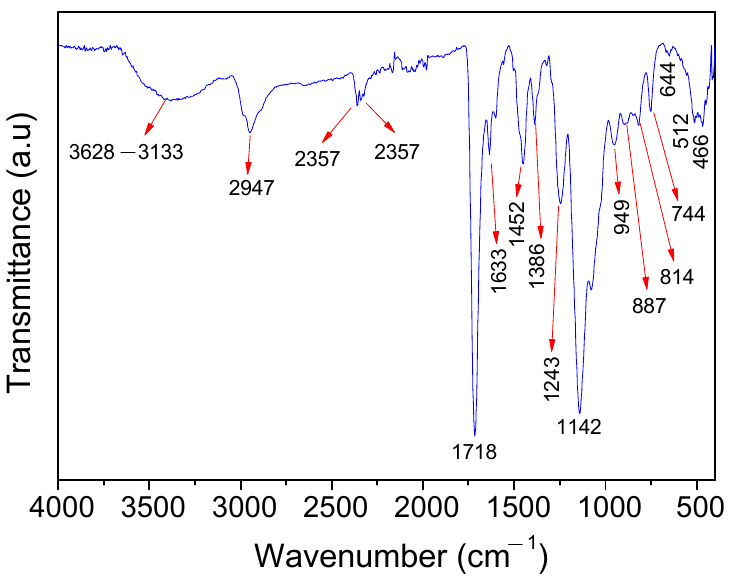
Figure 2. FTIR spectra of poly(protoporphyrin -co- vinyl pyridine).